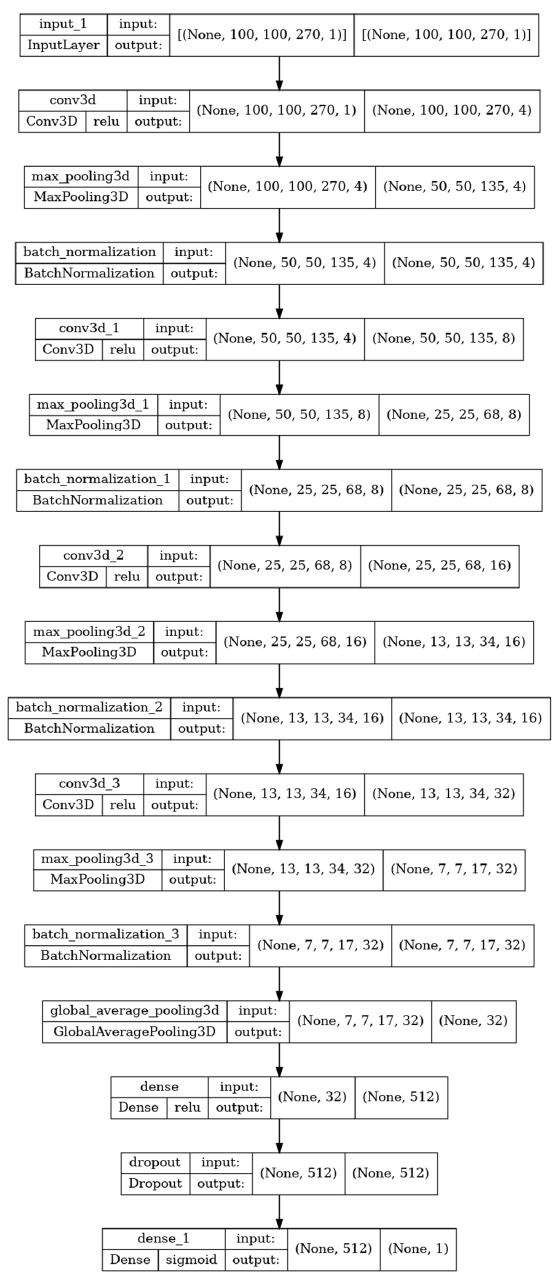
Figure A1. Topology of 3D-CNN utilized for HSI data.